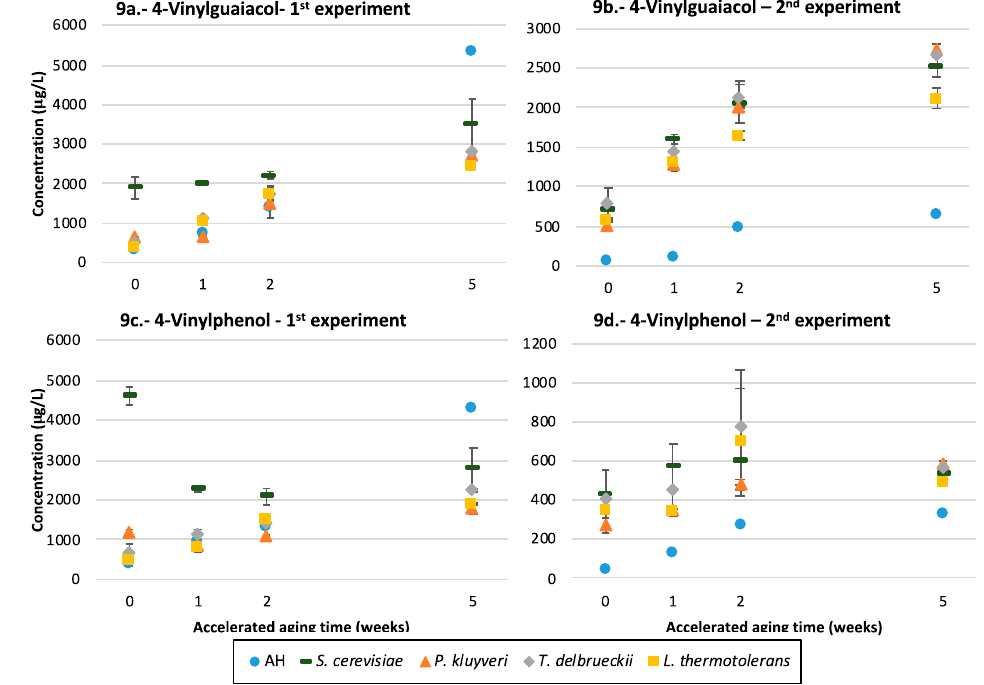
Figure 9. The volatile phenols formation in Riesling and Garnacha—the average concentration of ( a , b ) 4-vinylguaiacol and ( c , d ) 4-vinylphenol in wines fermented with different yeast strains or unfermented controls spiked with glycosidic precursors from Riesling (1st experiment) and Garnacha (2nd experiment) and its evolution during accelerated aging.